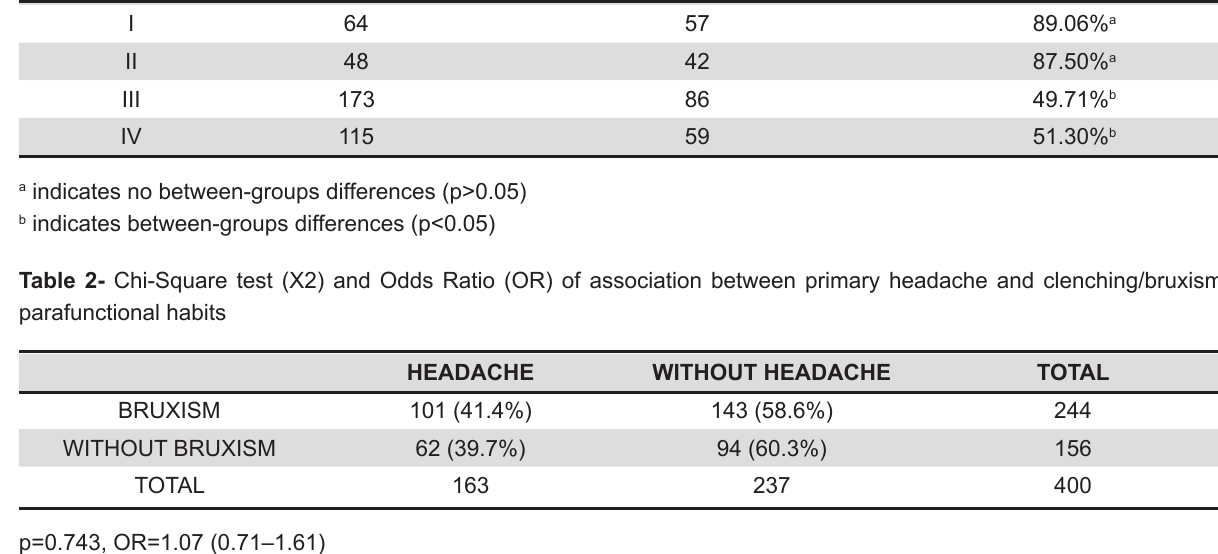
therapy* indicates within-groups differences (p<0.05) aa indicates no between-groups differences (p>0.05) ab indicates between-groups differences (p<0.05) Figure 1- Pain intensity according to Visual Analogue Scale (VAS) at baseline and in the end of the Table 1- Percentage of clenching/bruxism parafunctional habits between groups GROUP